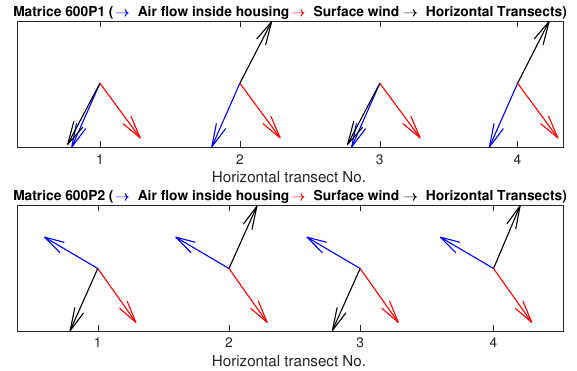
Figure 12. The figure shows the air flow, surface wind, and transect direction during each of the four transect flights conducted during each of the three horizontal flights through the inversion